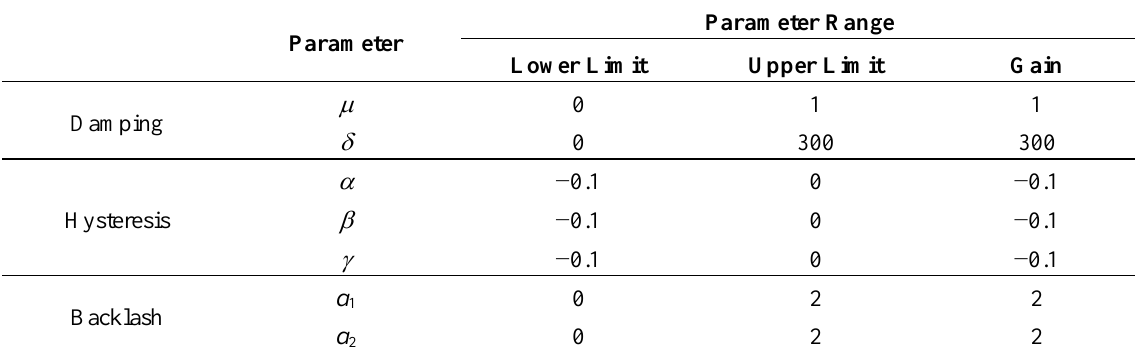
Table 3. Parameter ranges for the NN outputs.